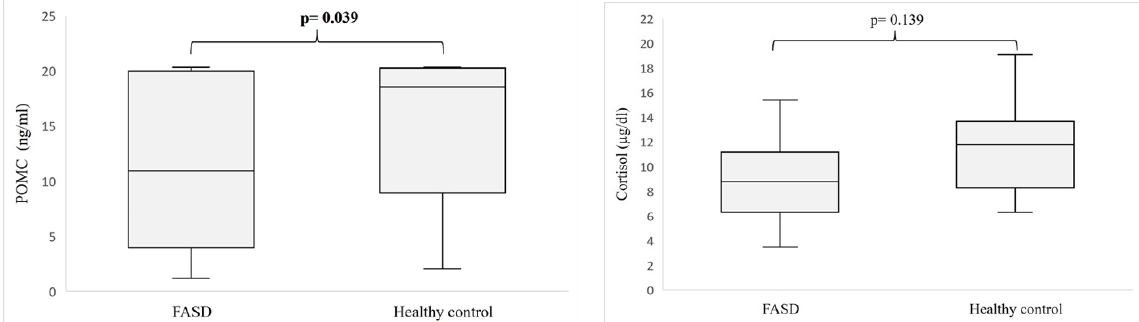
Figure 1. Level of POMC and cortisol in patients with FASDs compared to healthy participants. Abbreviations: POMC—proopiomelanocortin; FASD—fetal alcohol spectrum disorder. Comparisons